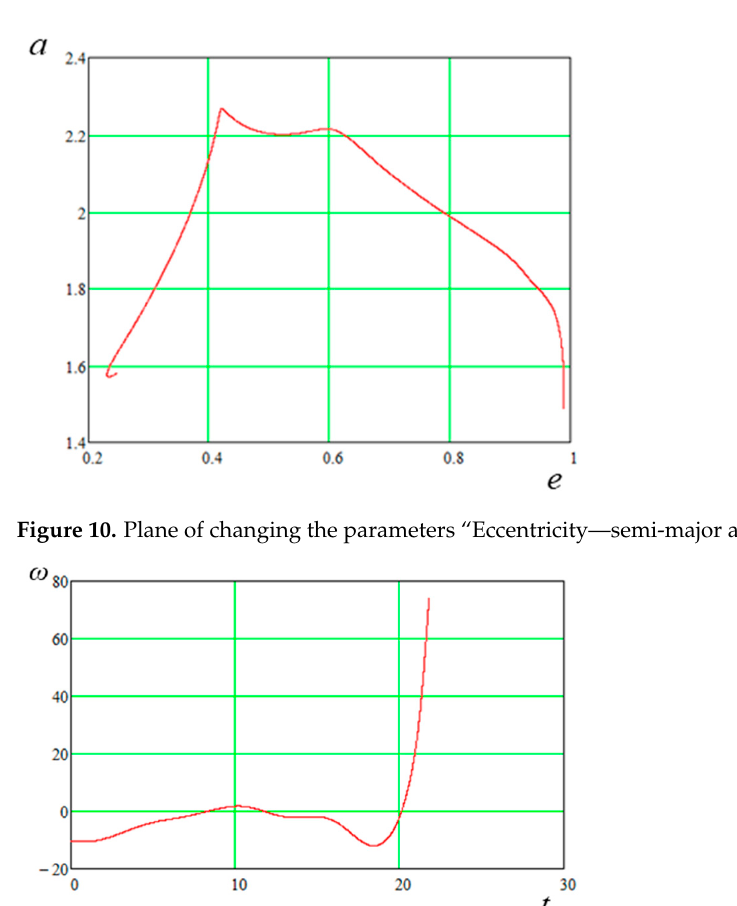
Figure 9. Osculating semi-major axis [undim.] of a transfer orbit on the flight time [undim.].